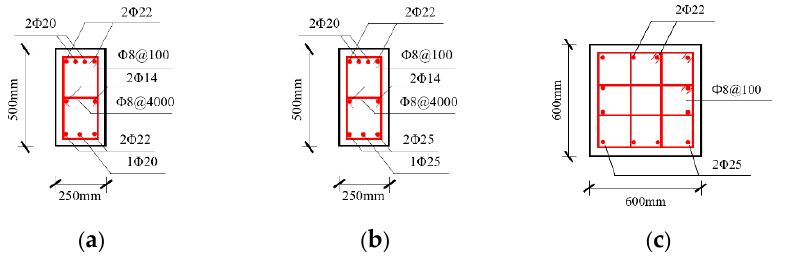
Figure 3. Structure diagram.